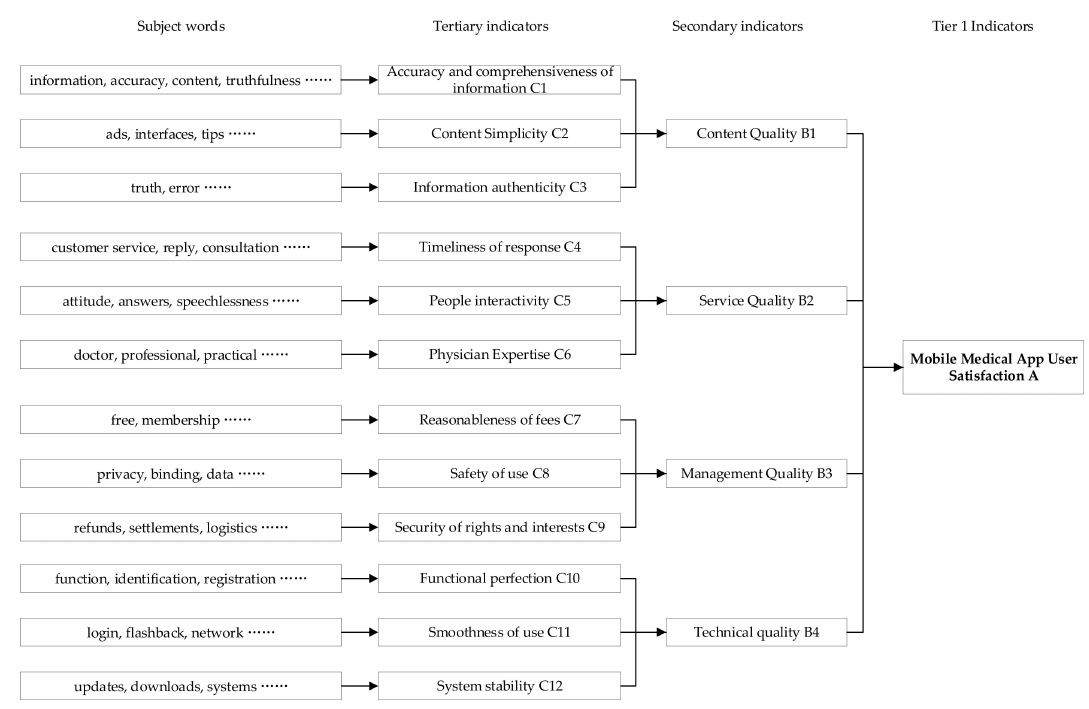
Figure 6. User satisfaction evaluation system for mobile medical apps.